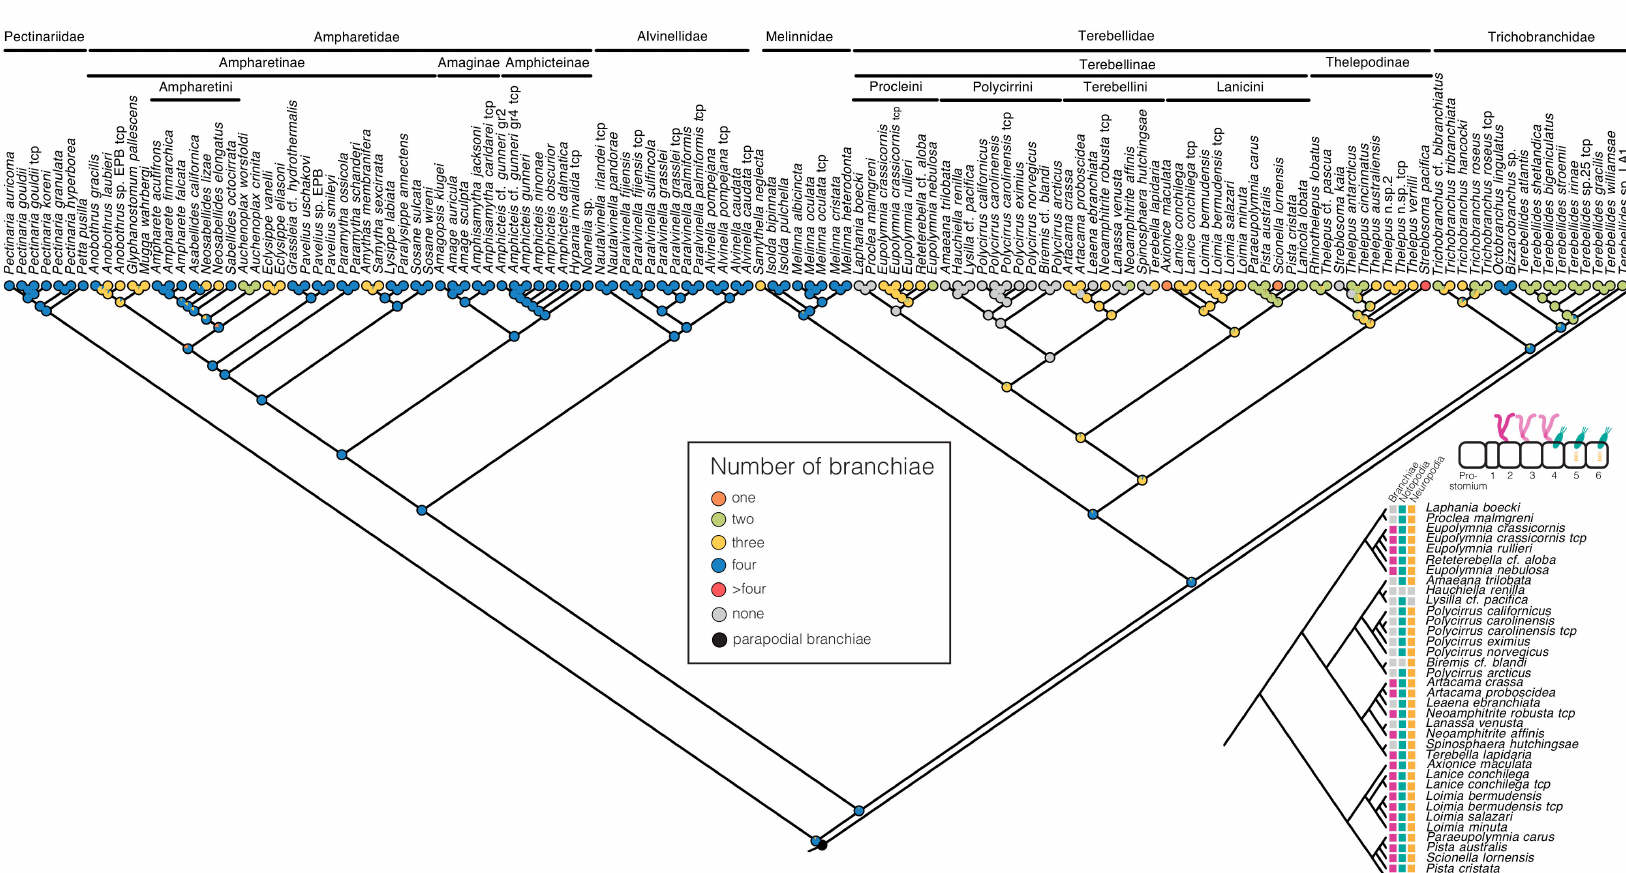
Figure 3. Evolution of the number of branchiae and chaetae in Terebelliformia. Maximum likelihood character reconstruction of the number of branchial pairs. Inset: Mapping of the presence (colored squares) or absence (gray squares) of branchiae, notochaetae and neurochaetae in Terebellinae showing complex patterns of